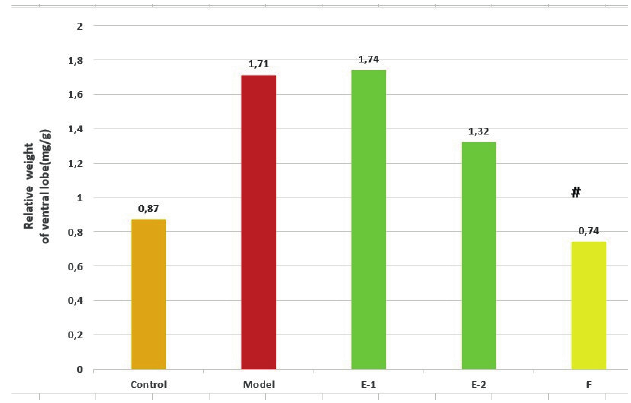
FIGURE 2 - Positive rate of cell apoptosis in the